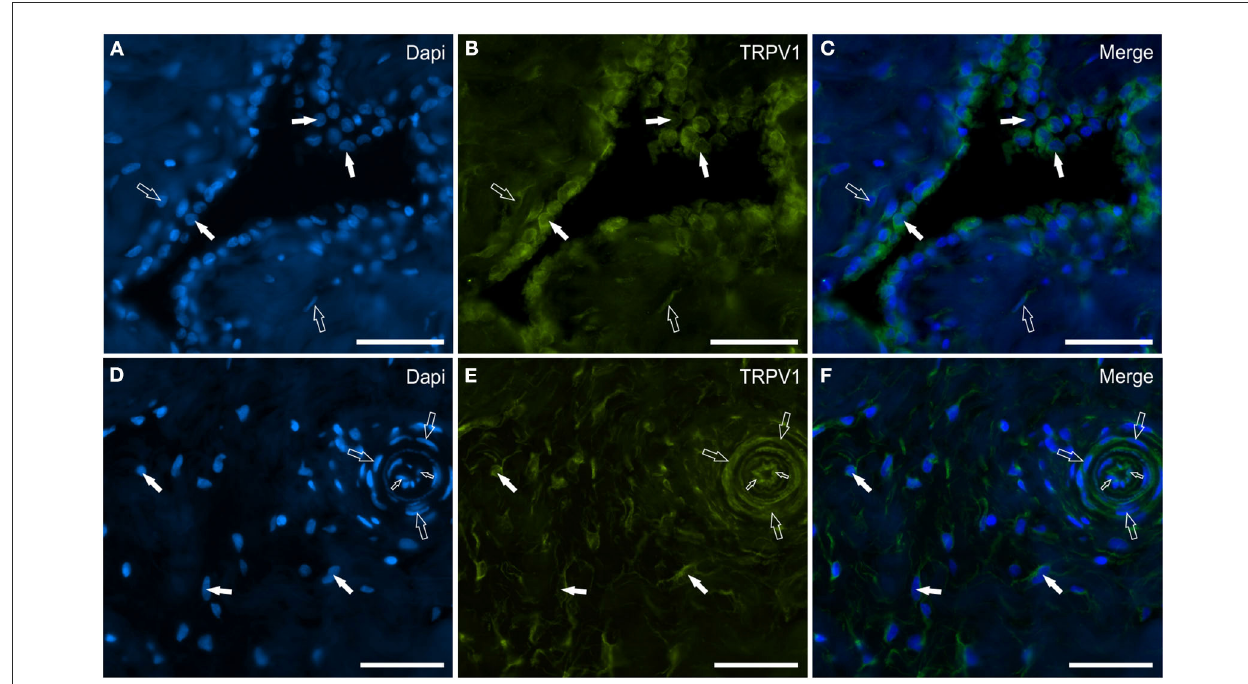
FIGURE6 Photomicrographs of the cryosections of the synovial membrane of a horse metacarpophalangeal joint showing transient receptor potential vanilloid 1 (TRPV1) (B, E) , immunoreactivity in synoviocytes (A–C) , and fibroblast and vascular cells (D–F) . (A–C ) The white arrows indicate the DAPI (Blue) labeled nuclei of some round synoviocytes expressing bright TRPV1 (Green) immunoreactivity. The open arrows indicate subintimal cells (likely fibroblasts) showing faint-to-moderate TRPV1 immunoreactivity. (D–F) The open arrows indicate the DAPI (Blue) labeled nuclei of some cells of the interstitial connective tissues of the synovial membrane (close to the subintima) expressing moderate-to-bright TRPV1 (Green) immunoreactivity. The open arrows and the small open arrows indicate the DAPI labeled nuclei of the vascular smooth muscle cells and endothelial cells, respectively, expressing moderate TRPV1 immunoreactivity. (C, F) Merged images. Scale bar = 50 µ